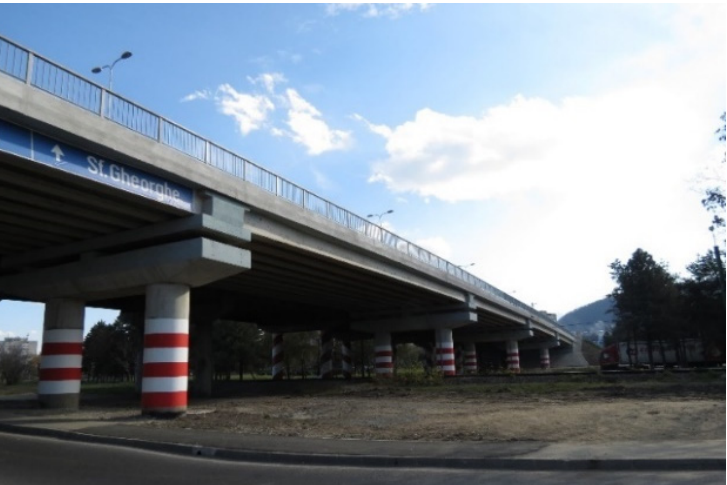
Figure 2. Fartec bridge in Brasov, Romania.